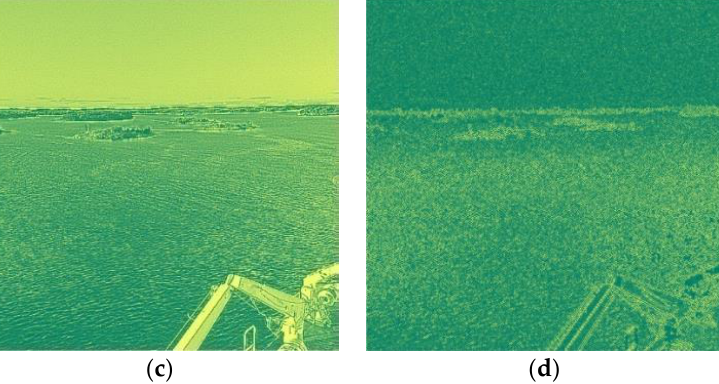
Figure 3. Cover image, SRM, high-boost, high-boost with SRM filtered image. ( a ) Cover image. ( b ) SRM filtered image. ( c ) High-boost filtered image. ( d ) SRM filtered image of Figure 3c.